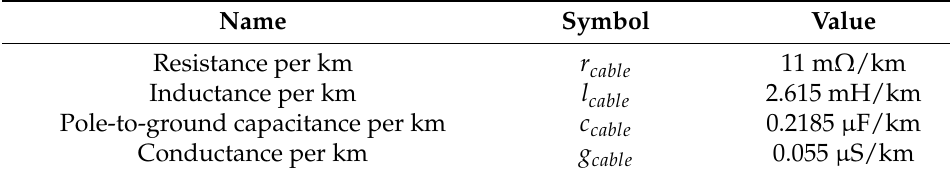
Table 4. Macroscopic characteristics of a ± 200 kV DC cable